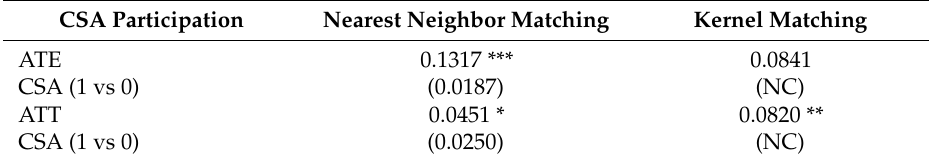
Table 9. Treatment effects of CSA participation on technical efficiency.